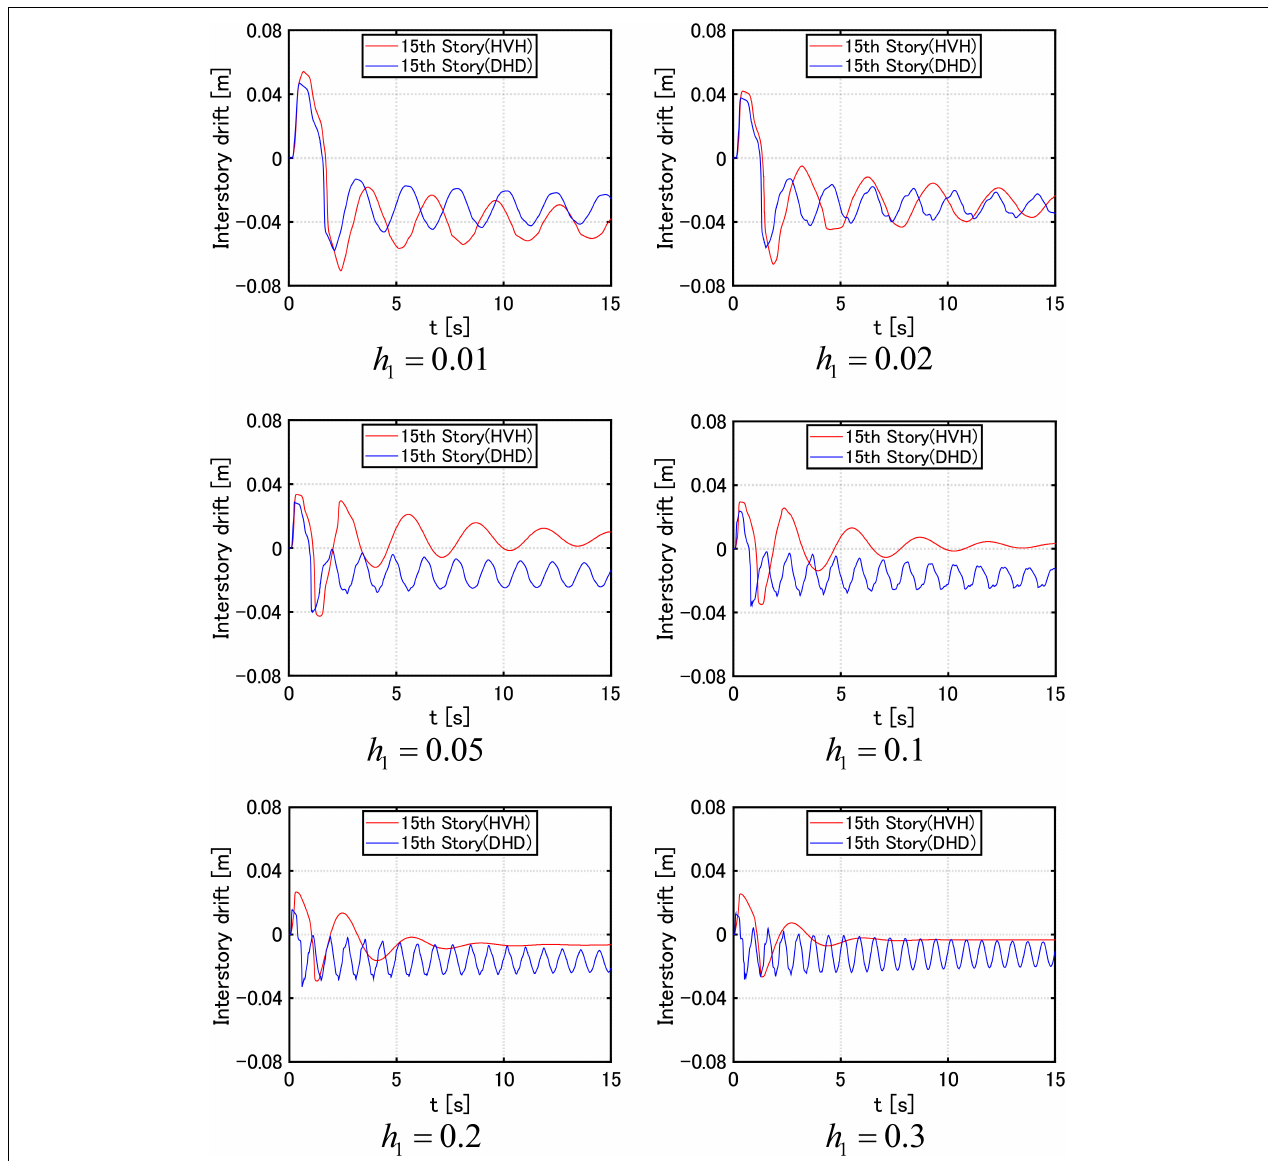
FIGURE 8 | Time history of 15th-story inter-story drift of MDOF systems with HVH system for various damping levels h 1 = 0 . 01 , 0 . 02 , 0 . 05 , 0 . 1 , 0 . 2 , 0 . 3 of viscous dampers and with DHD system of equivalent damper quantity of DSA (using Eq. (18)) under critical double impulse with V = 2.0 (m/s).